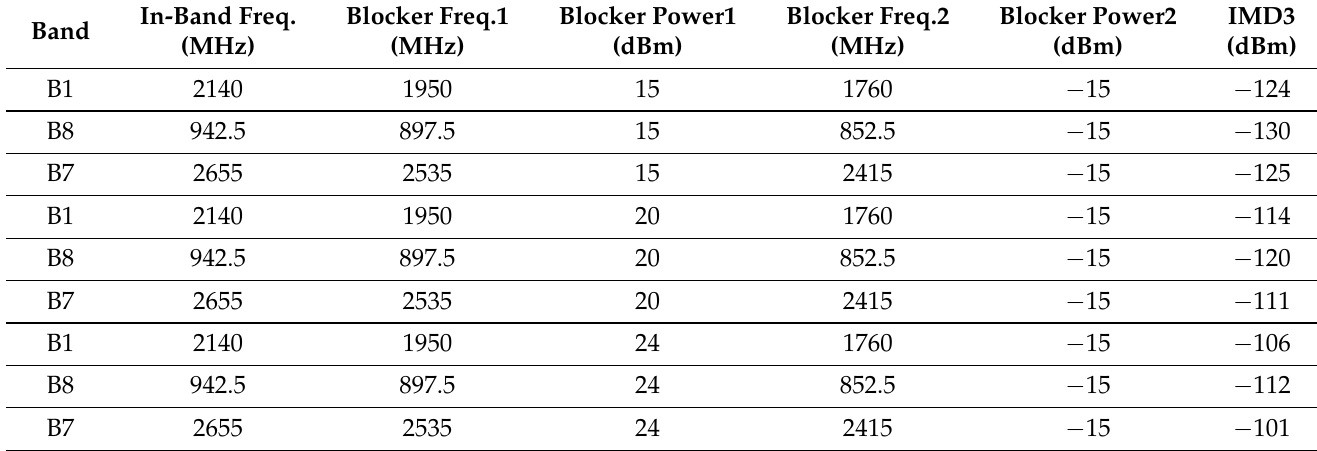
Table 2. IMD3 measurement summary.